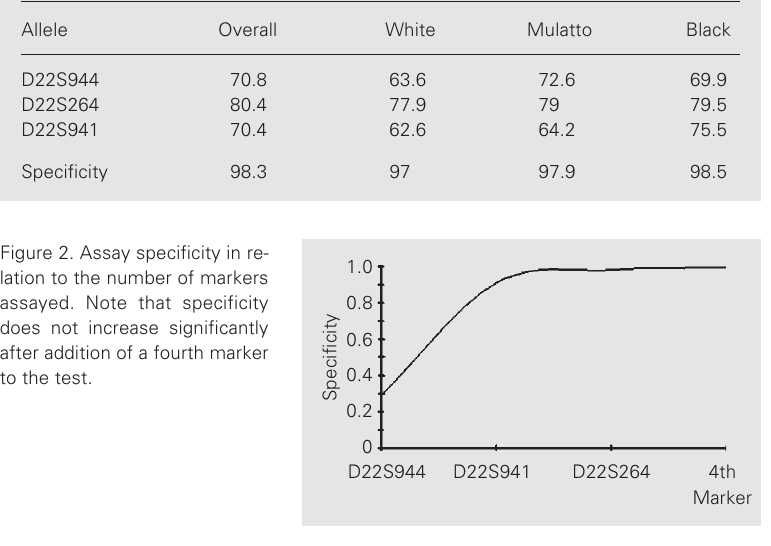
Table 2. Sample heterozygosity index.